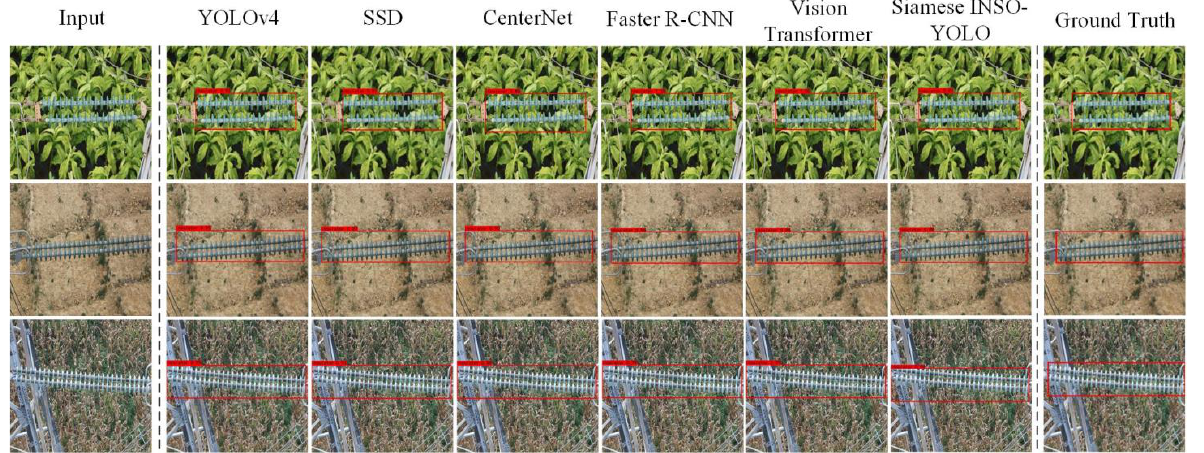
Figure 4. Test results of each model on the InsuDaSet dataset. The experimental results show that the test accuracy of Siamese ID-YOLO is similar to that of Faster R-CNN, Vision Transformer, and it